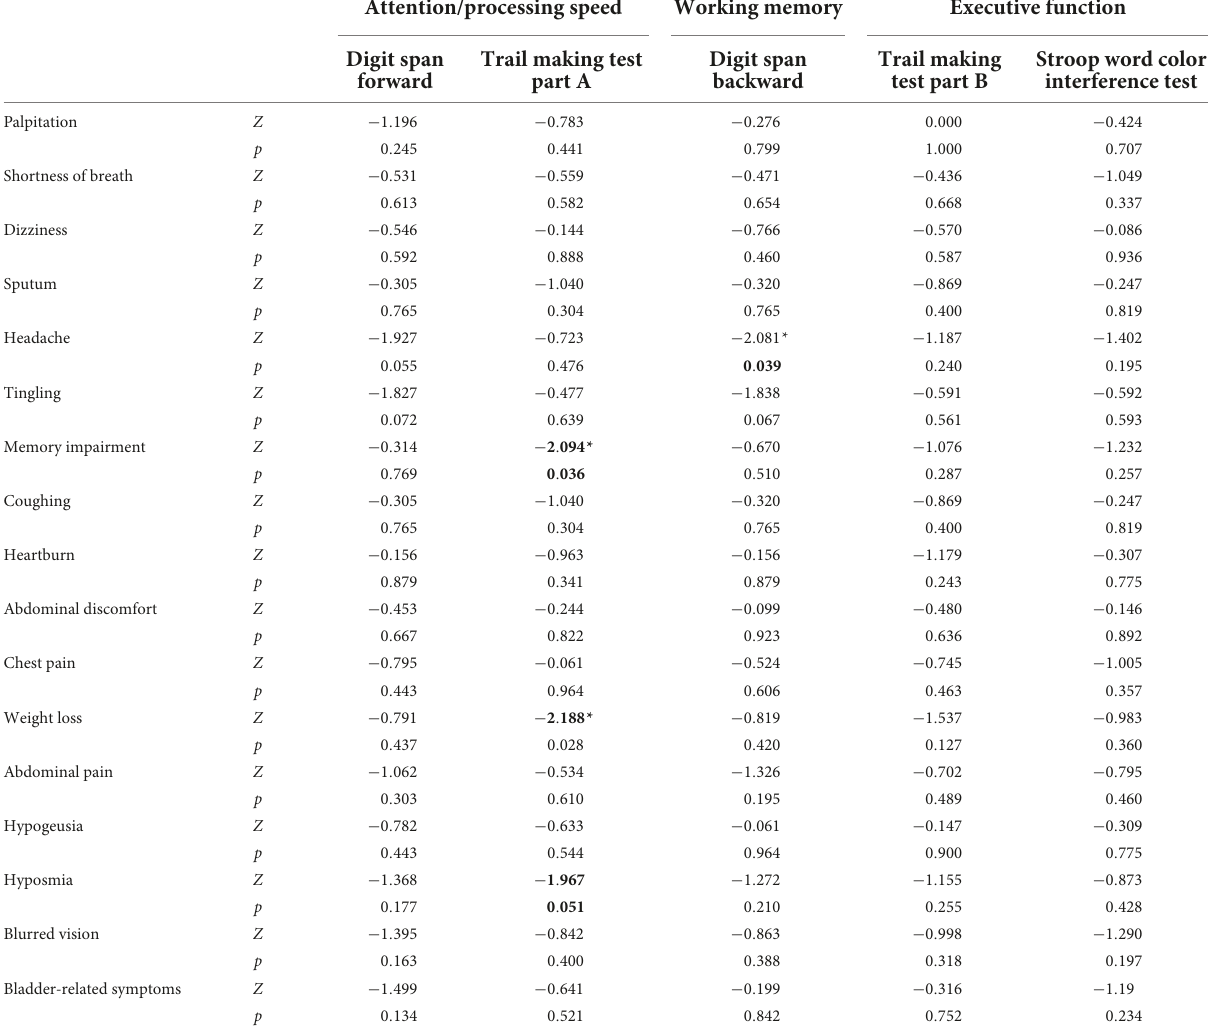
TABLE 6 Comparisons of the cognitive test results across the subjective symptoms. Attention/processing